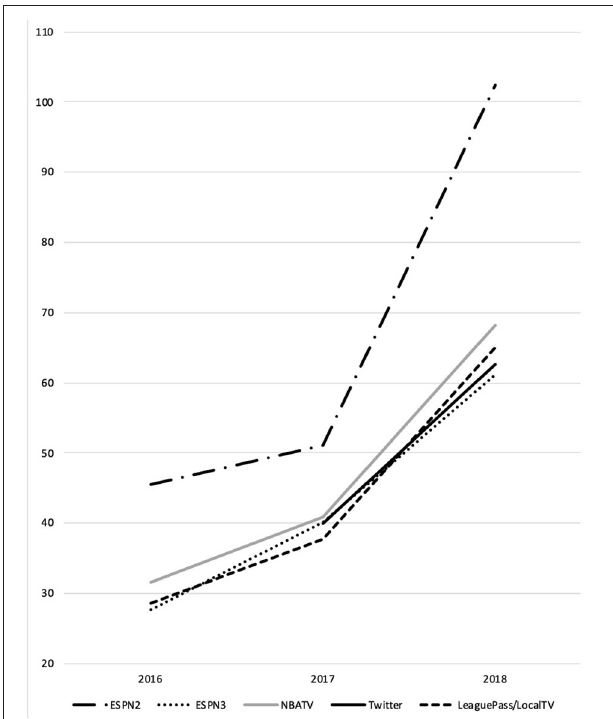
FIGURE 1 | Average of home and away team interactions per Twitter post, WNBA 2016 − 2018.